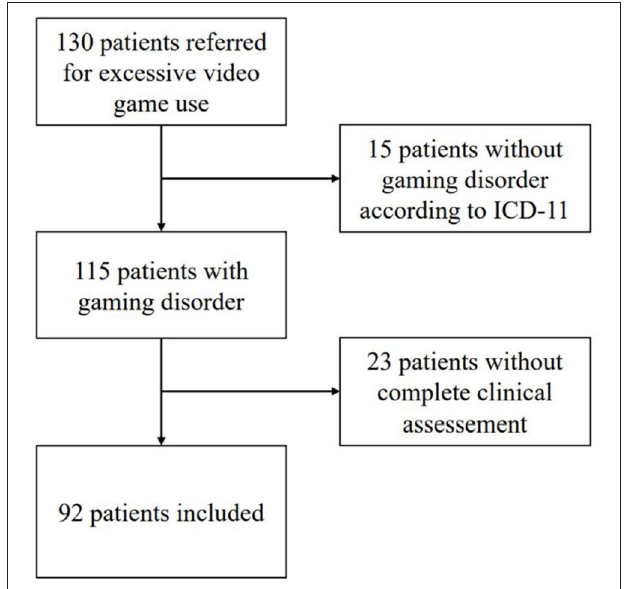
FIGURE 1 | Flow chart of patients participating in the study from August 2012 to August 2020.